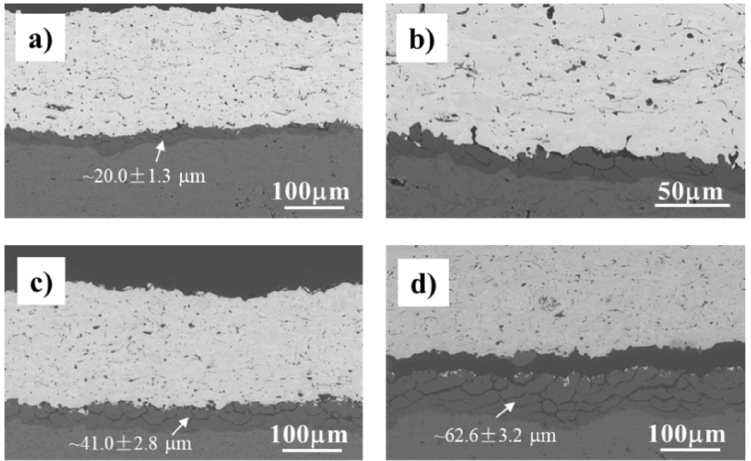
Figure 8. SEM images of APS EBCs in steam cycling showing the TGO growth. ( a , b ) 200 cycles; ( c ) 400 cycles; ( d ) 600 cycles.